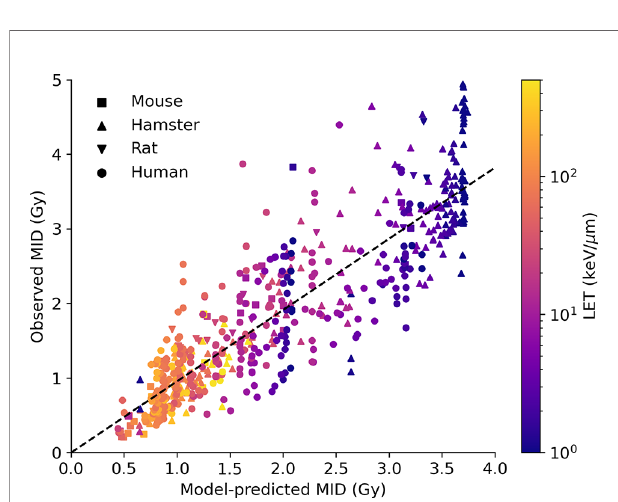
FIGURE 5 | Impact of high LET on radiosensitivity. Predicted MID for acute ion exposures (x-axis) is compared to observed MIDs for a range of cell lines (points, coloured by species of origin) for LETs between 1 and 1,000 keV/ m m. Again, the model effectively captures the range of sensitivity, and its dependence on both underlying biology and physics. Best fi tting line has a slope of 0.96, with an R 2 of